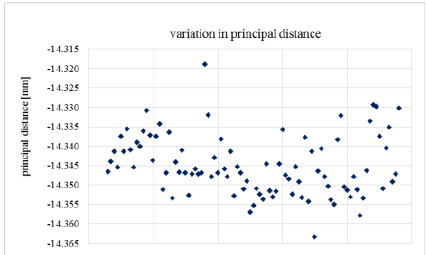
Figure 4. Variation in principal distance for Olympus